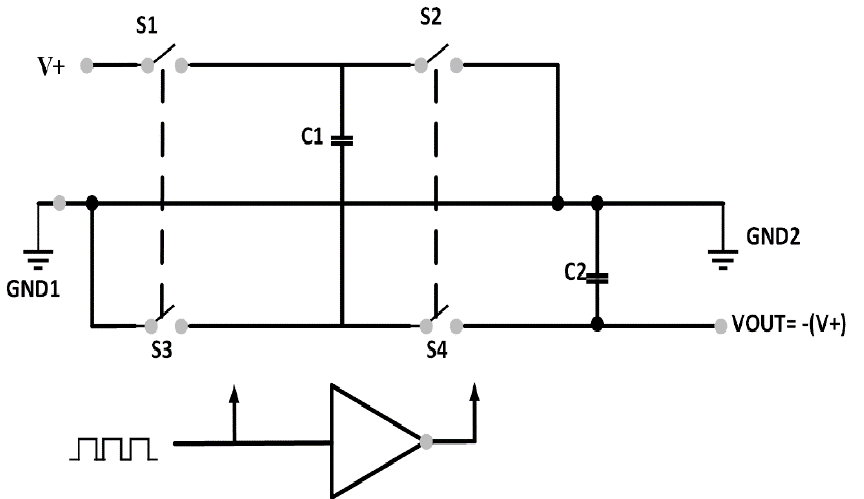
Figure 10. DC-DC Charge pump